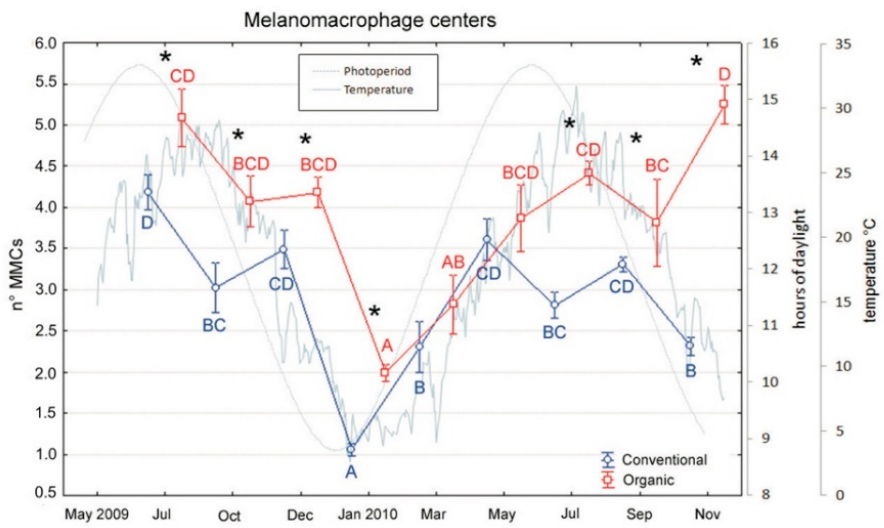
Figure 6. Variations in melanomacrophage centers number of sea bass over an 18-month period (mean ± SE) reared under conventional and organic aquaculture. Different letters indicate significant differences in samplings within the same feeding system (organic or conventional; p < 0.05). Asterisks indicate significant differences between feeding systems within the same sampling ( p < 0.05).